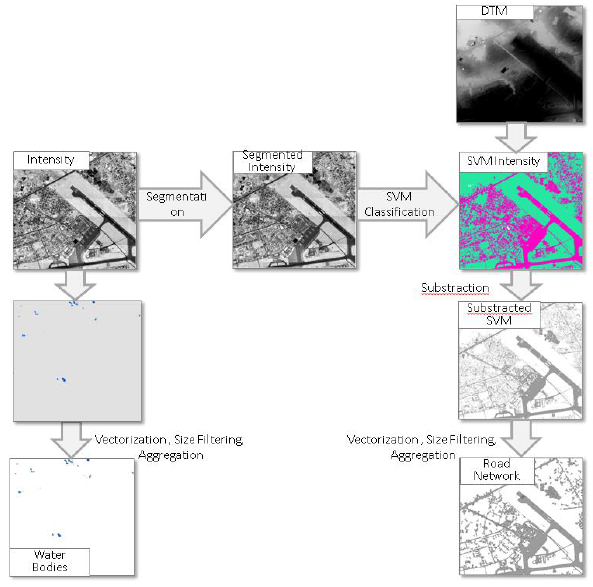
Figure 4. The road and water-bodies extraction methodologies